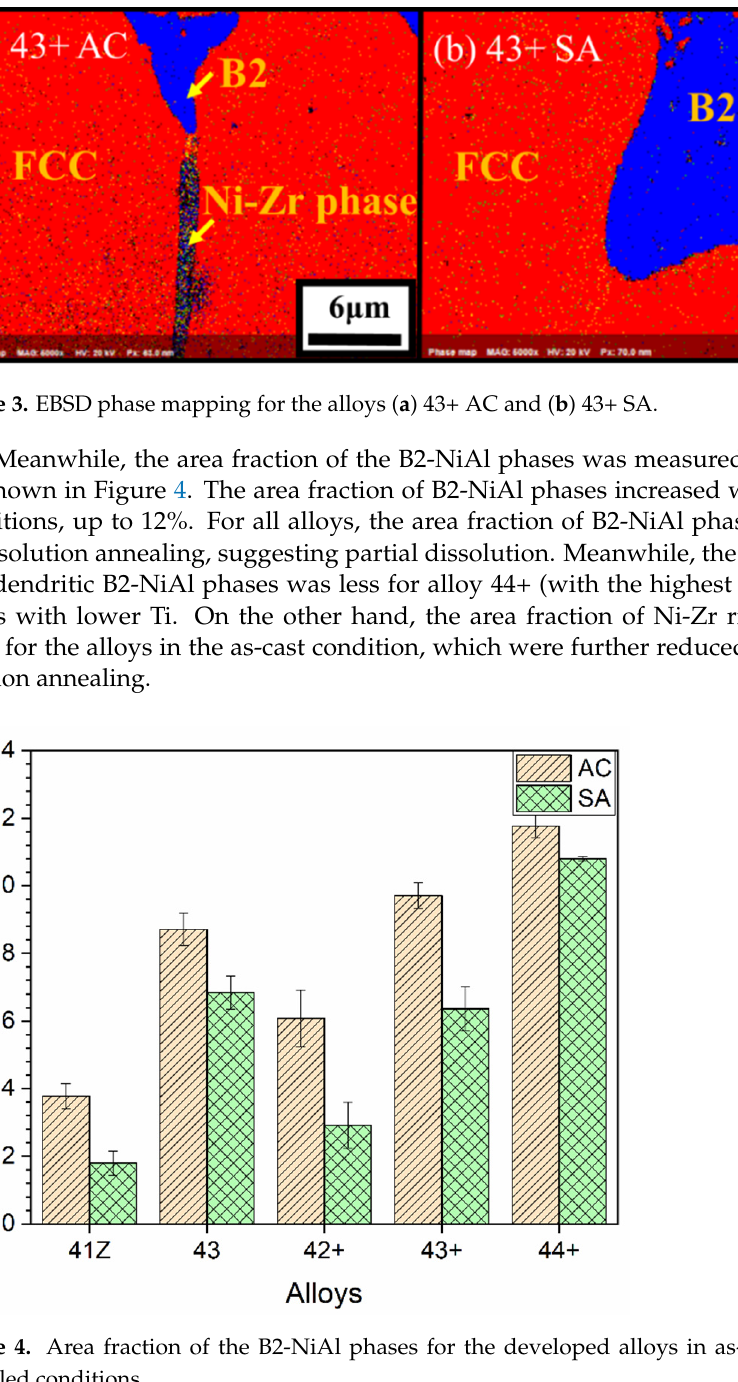
Figure 3. EBSD phase mapping for the alloys ( a ) 43+ AC and ( b ) 43+ SA.